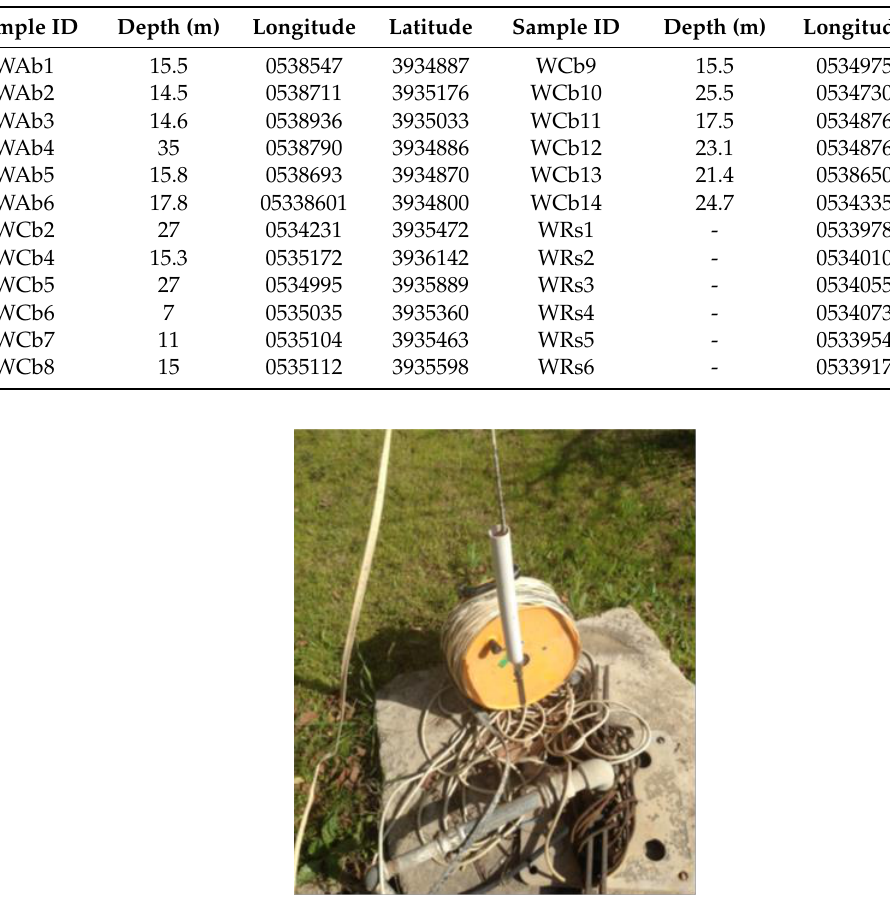
Table 4. Groundwater and surface water samples locations and depth.